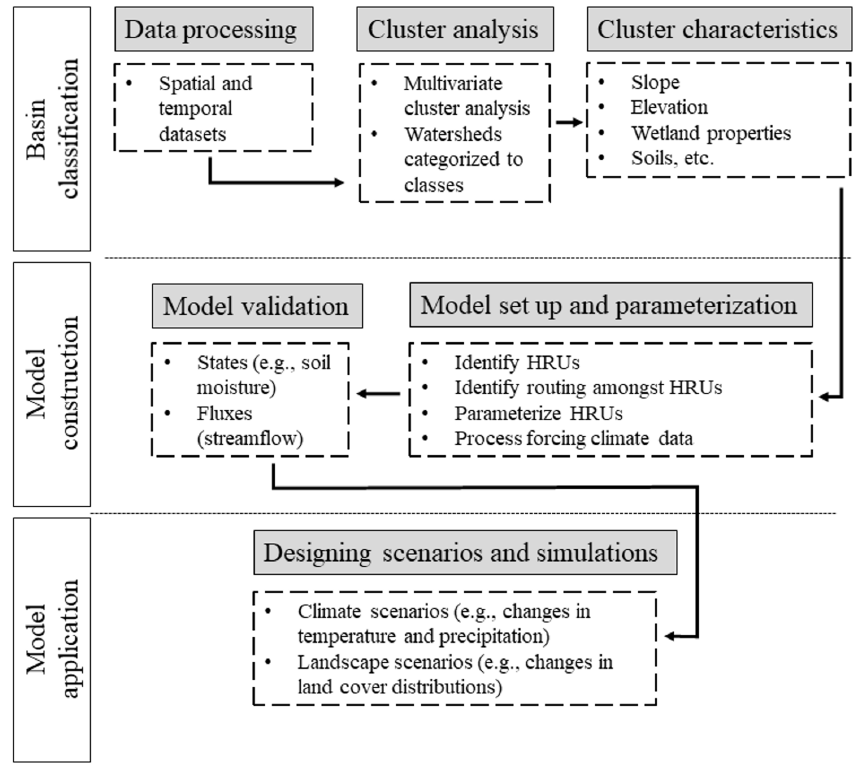
Figure 1. Components of the classification-based virtual basin modelling